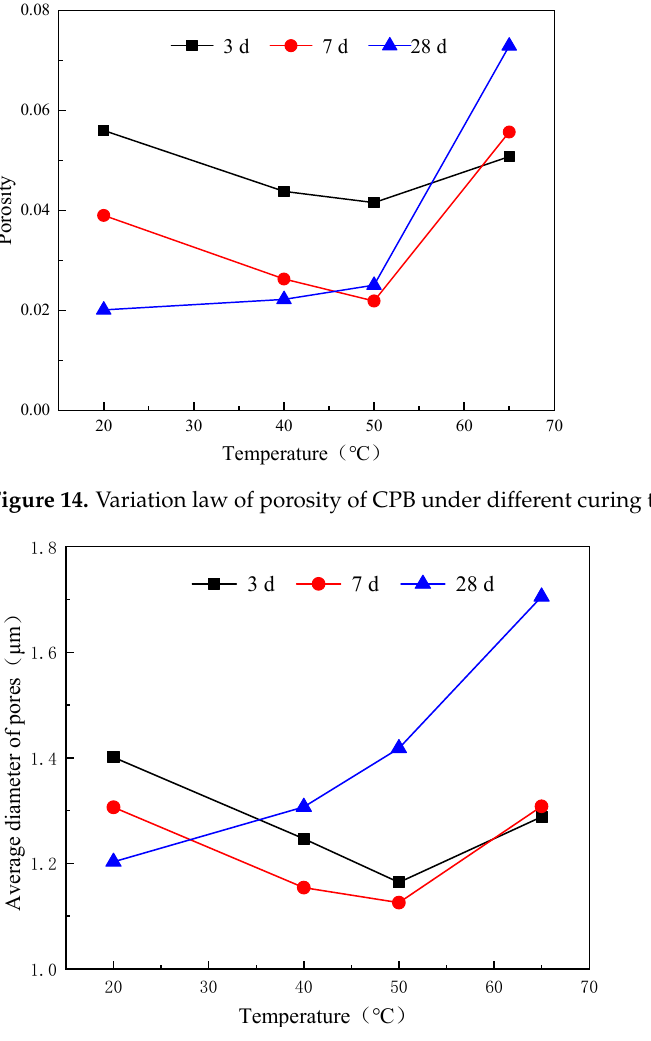
Figure 15. Variation law of average pore diameter of CPB at different curing temperatures.